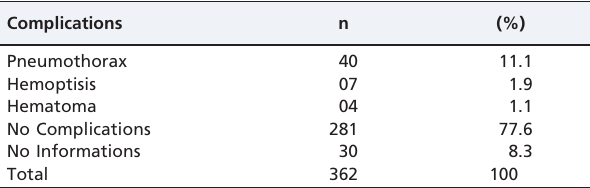
Table 2 - Distribution of complications rates of CT-guided FNAB of lung lesions.